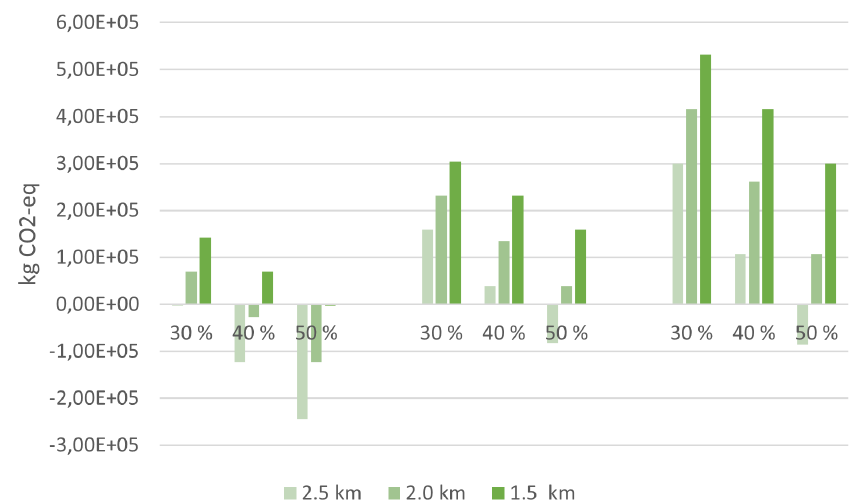
Figure 4. In the figure are the result for the first 30 years (left), the remaining 30 years (middle), and total emissions (right-hand side) when embodied emissions are reduced 88 % compared to the reference value for the first period